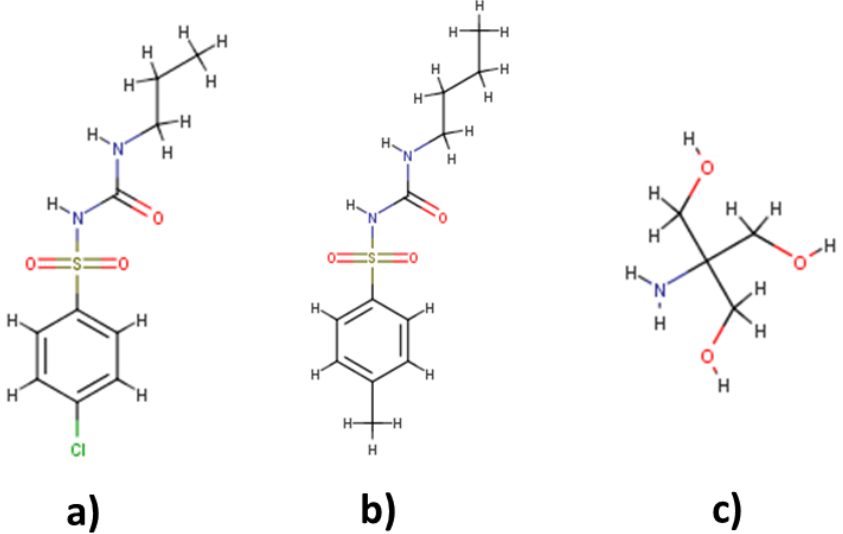
Figure 1. Structures of chlorpropamide (CLP) ( a ), tolbutamide (TLB) ( b ), and tromethamine (TRIS) ( c ).